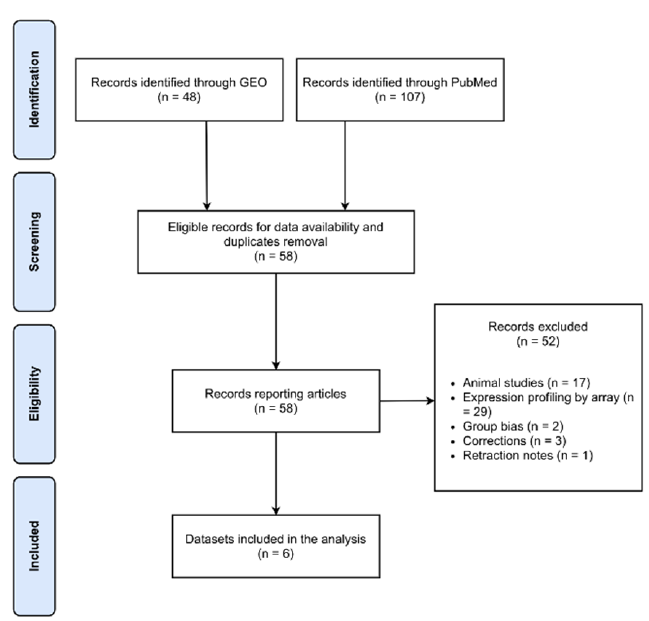
Figure 7. PRISMA flow diagram showing the step-by-step process of our search and selection applied during systematic data retrieval.